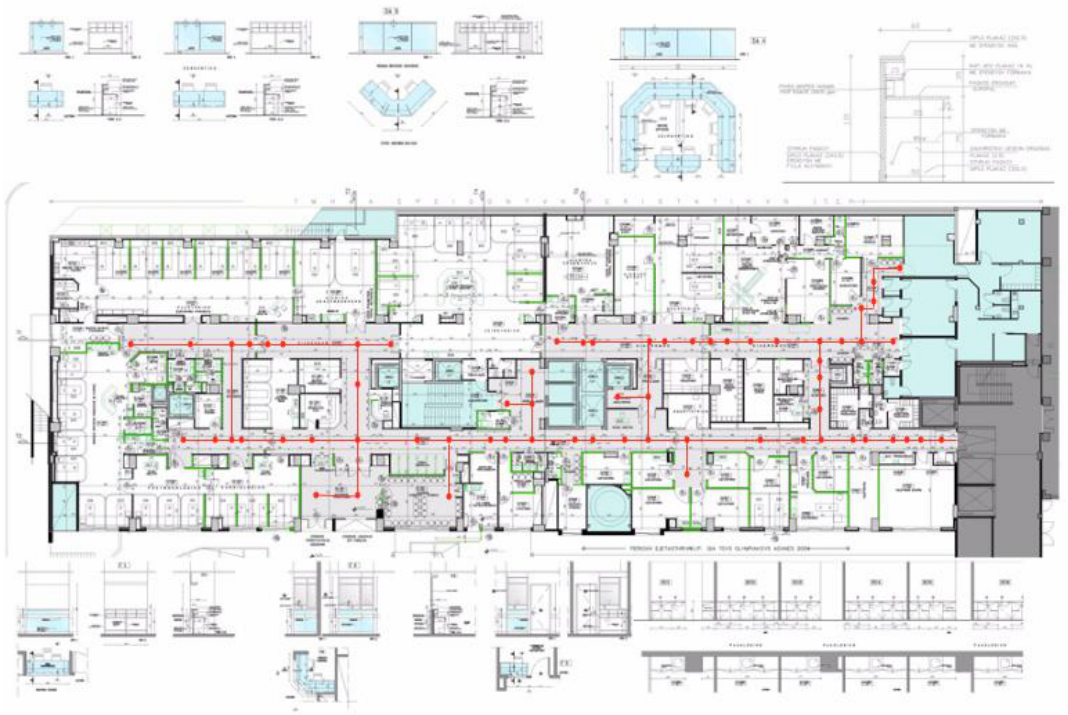
Figure 11. Floor plan of the Department of Emergency Incidents (DEI) of Evangelismos Hospital, the